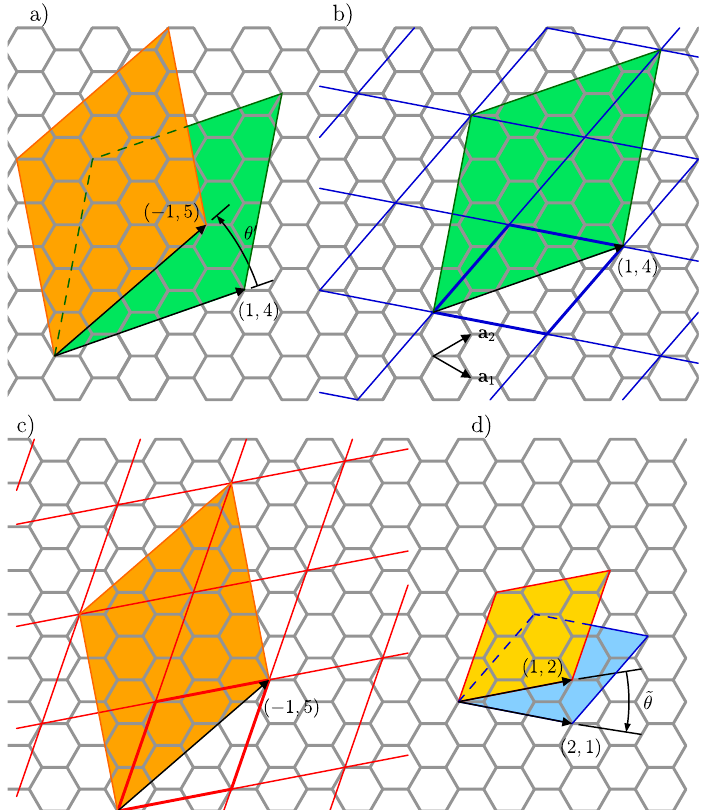
Figure 8: a) Construction of the moiré bilayer based on the ( 1,4 ) supercell for the lower layer and the ( − 1,5 ) for the upper layer. b) The lower supercell can be tes- sellated by the ( 2,1 ) smaller supercell. c) The upper one is also a tessellation of the ( 1,2 ) supercell. d) The angle of the “left-hand” small moiré is the same as that of the = − θ ′ large non-primitive moiré ˜ θ { 2,1 } { 1,4 }